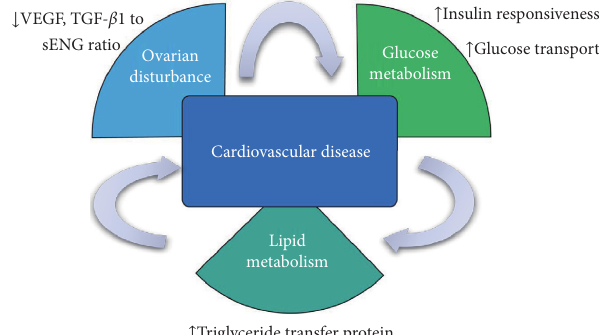
Figure 9: Potential mechanism of therapeutic effect of vitamin D on women with